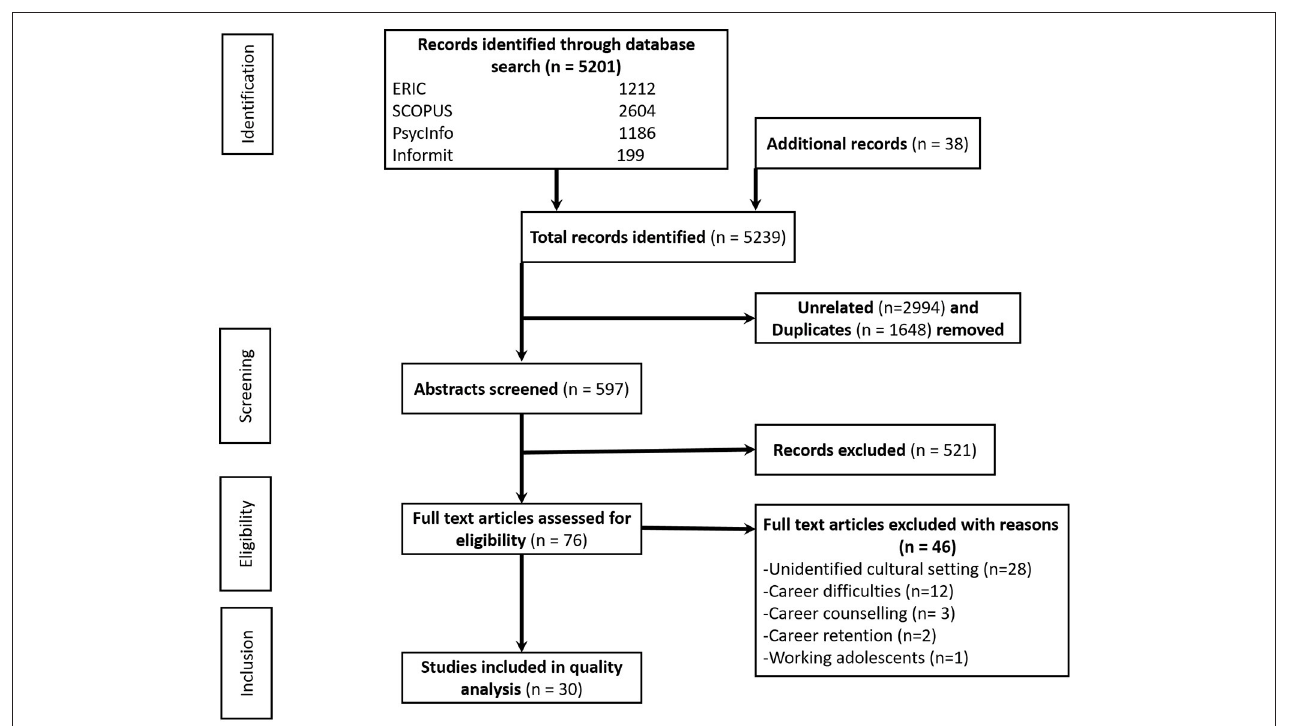
FIGURE 1 | Search strategy. The figure shows the search strategy including databases assessed for this study.